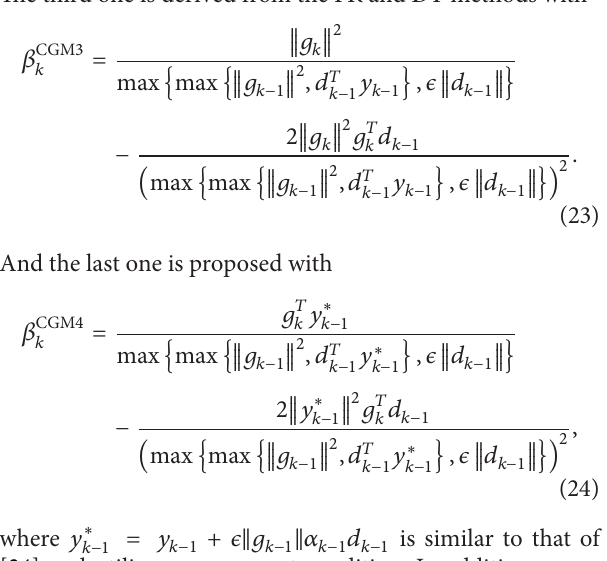
Figure 1: Performance profile based on the number of function